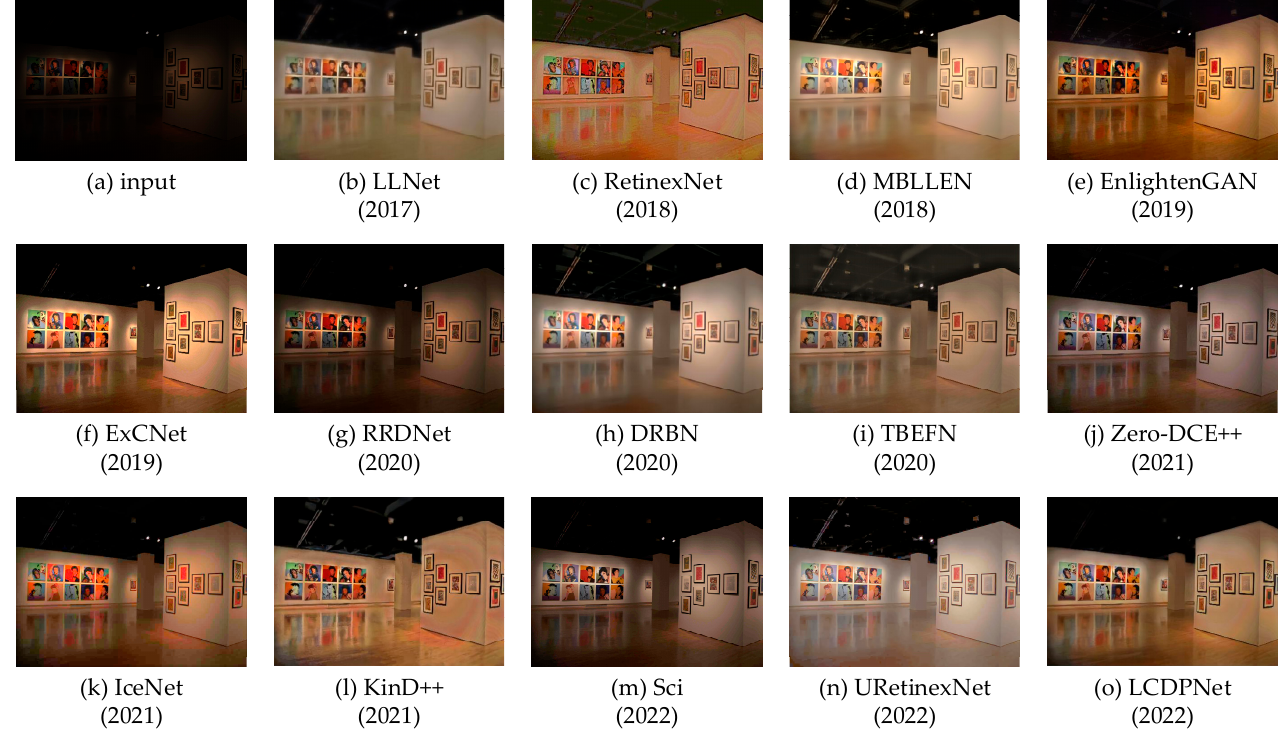
Figure 8. Visual results of different algorithms on low-illumination images sampled from the SICE dataset.